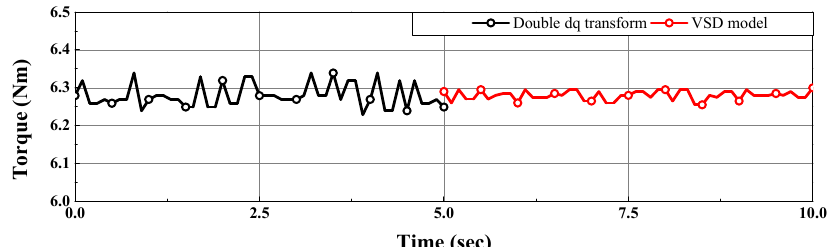
Figure 10. Torque profile of experimental results according to coordinate transformation method in healthy operation.